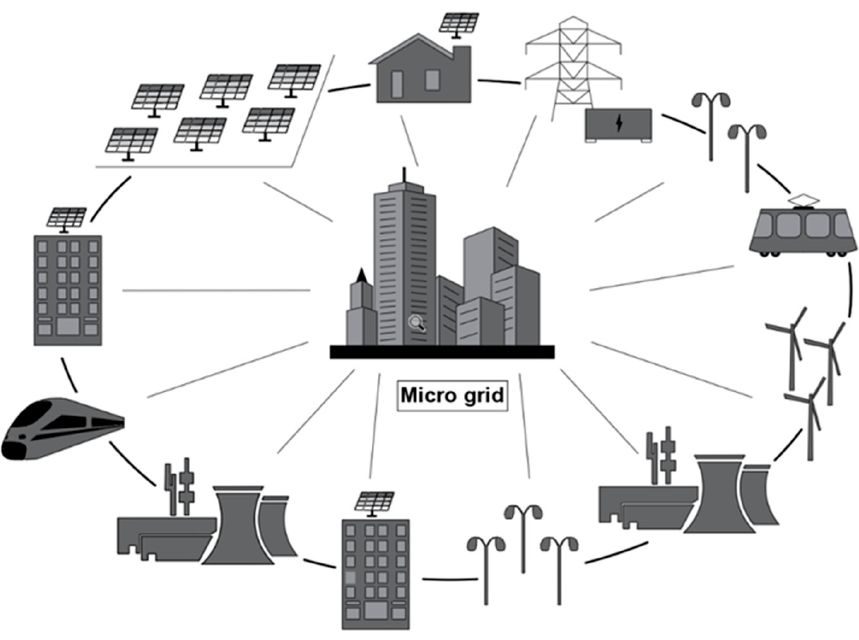
Figure 2. A smart microgrid as part of a cluster of buildings.